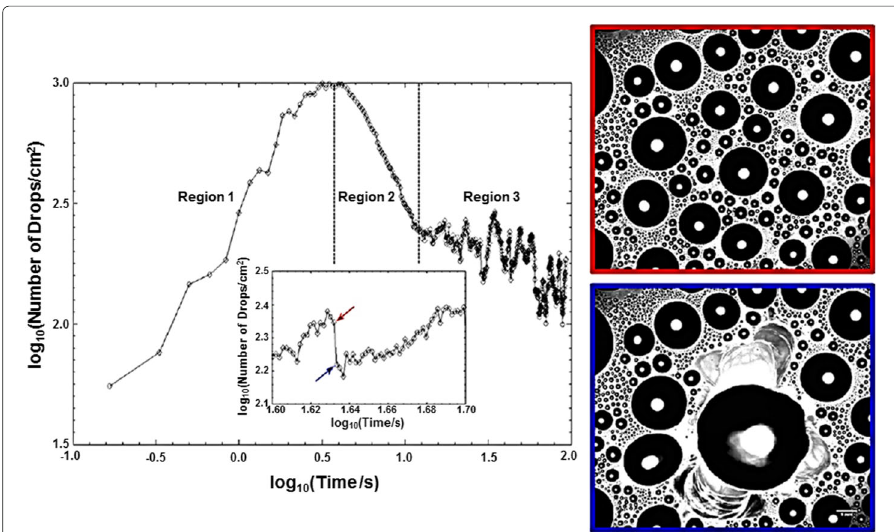
Fig. 1 Growth curve. (left) Growth curve for a uniform dodecyl surface exposed to a constant source of steam and constant cooling. (right) Images just before (red) and just after (blue) a large scale coalescence event, also indicated by arrows in inset of sawtooth. A sharp decrease in the number density coincides with clearing a large surface area. This figure is taken from the work of Macner et al.